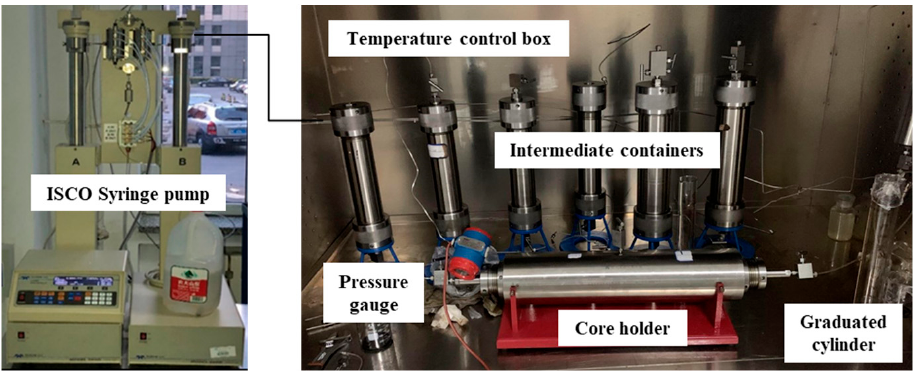
Figure 2. Photographs of the experimental set-up.